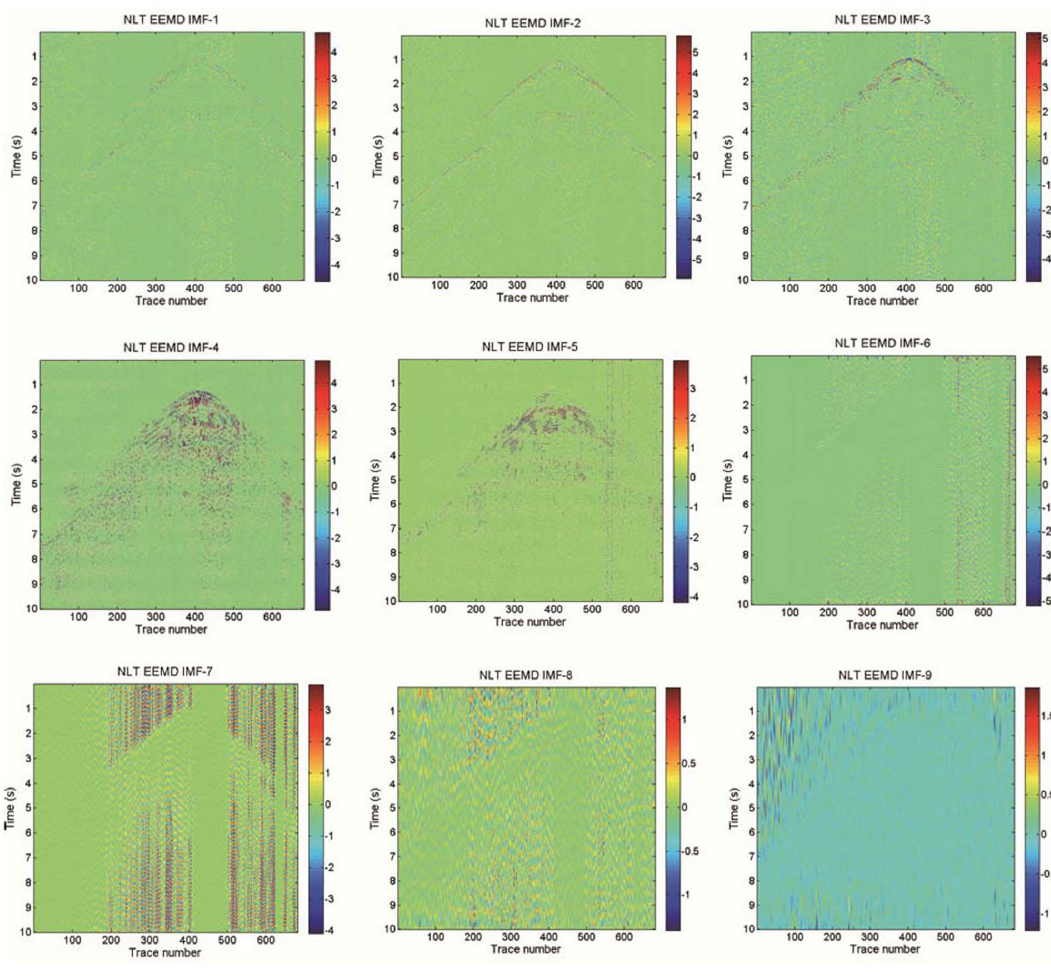
Fig. 8. Filter bank of the OBS data with logarithmic transform.